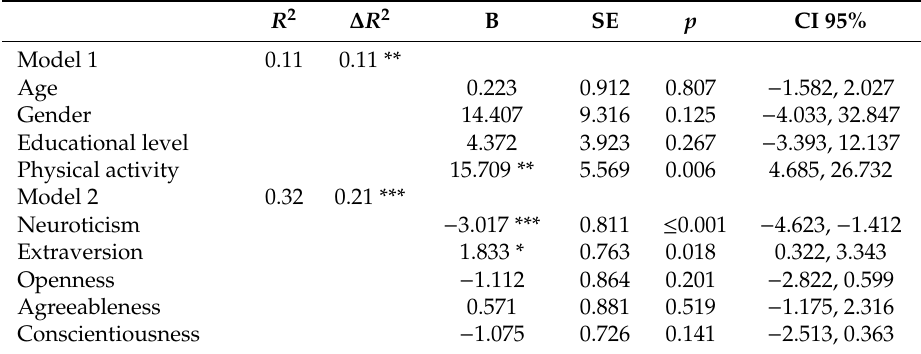
Table 4. Relationship between personality traits and subjective-physical